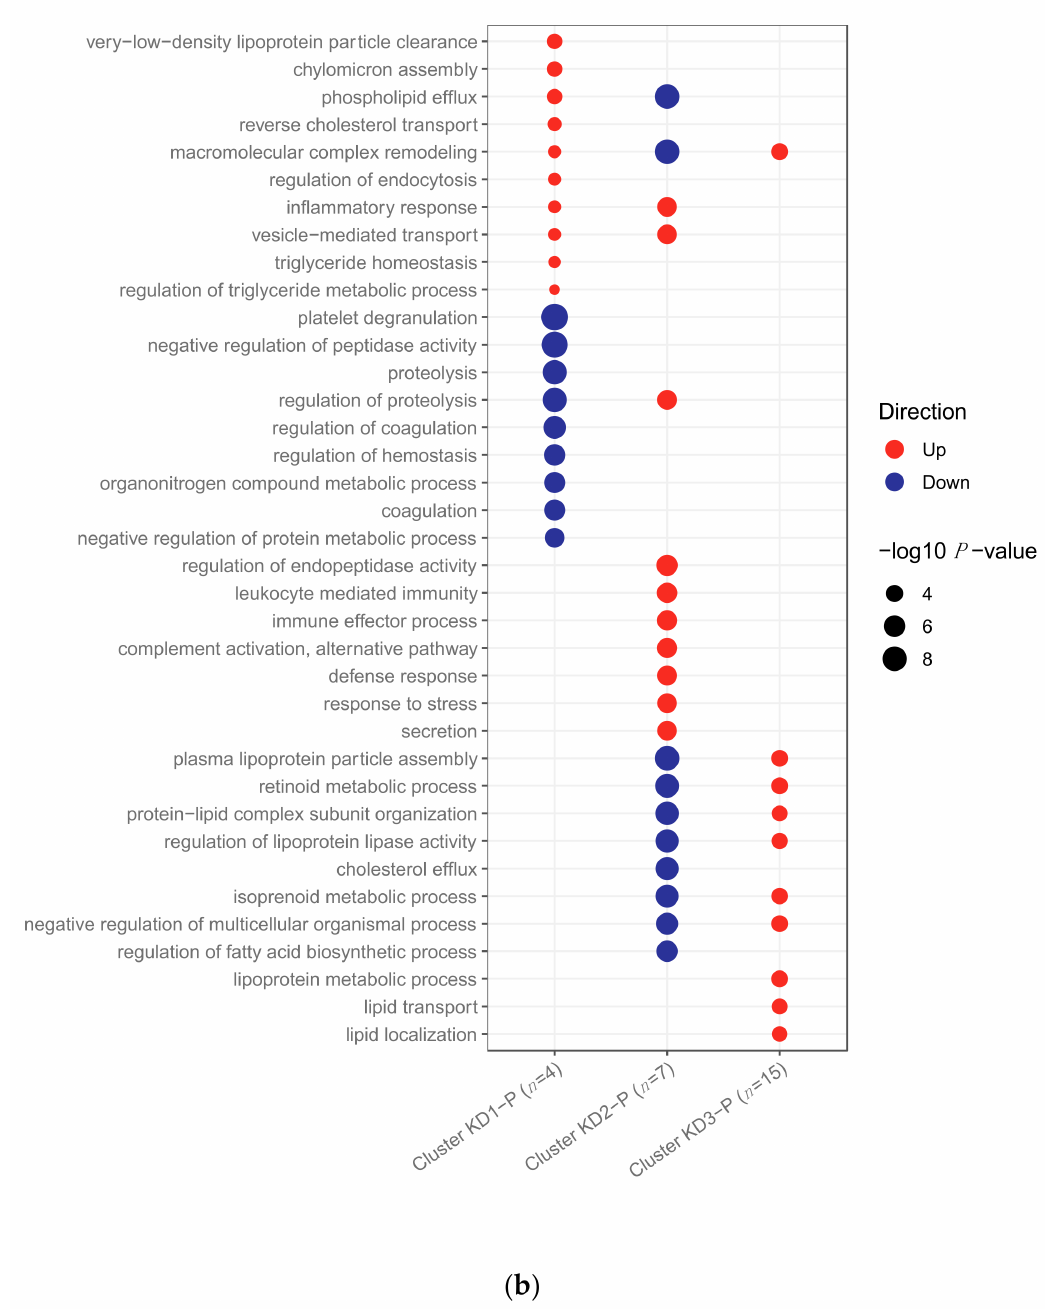
Figure 6. ( a ) Pathways upregulated and downregulated in transcriptomic KD patients between clusters. Clusters were identified by K-Means ran on KD patients alone. There were 24, 118 and 24 pathways upregulated in clusters KD1-T, KD2-T and KD3-T, respectively, and 94, 68 and 75 pathways downregulated in clusters KD1-T, KD2-T and KD3-T, respectively. KD represents Kawasaki Disease. ( b ) Pathways upregulated and downregulated in proteomic KD patients between clusters. Clusters were identified by K-Means ran on KD patients alone. There were 77, 94 and 61 pathways upregulated in clusters KD1-P, KD2-P and KD3-P, respectively, and 64, 104 and 53 pathways downregulated in clusters KD1-P, KD2-P and KD3-P, respectively. KD represents Kawasaki